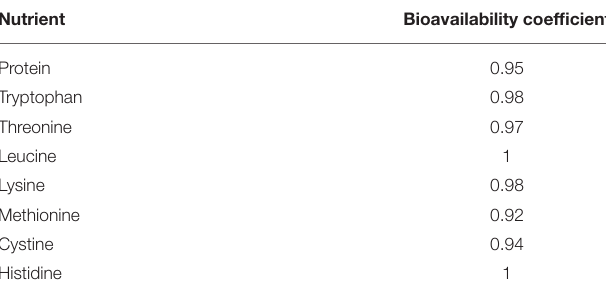
TABLE 2 | Bioavailability coefficients used for protein and indispensable amino acids in the DELTA Model for milk.